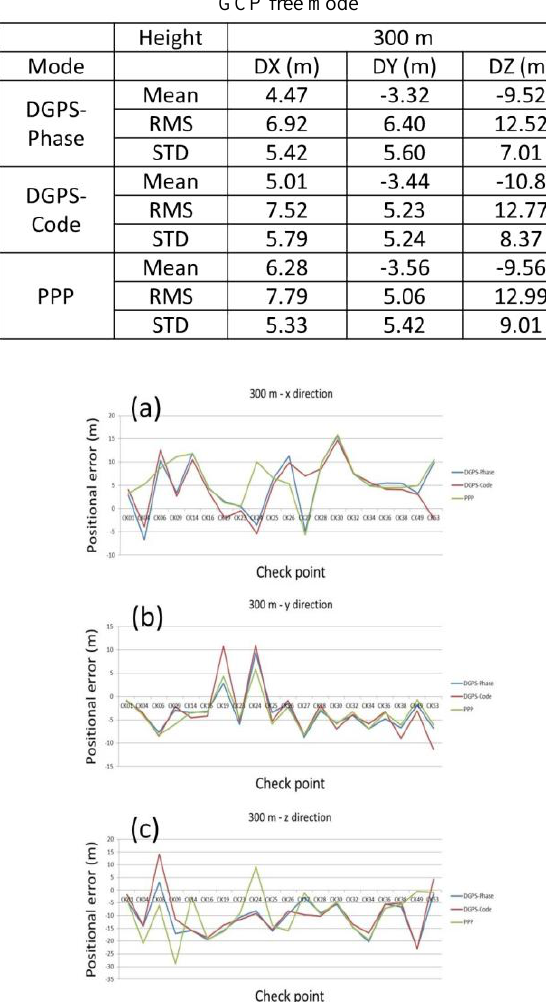
Table 4. Performance summary of proposed UAV platform in